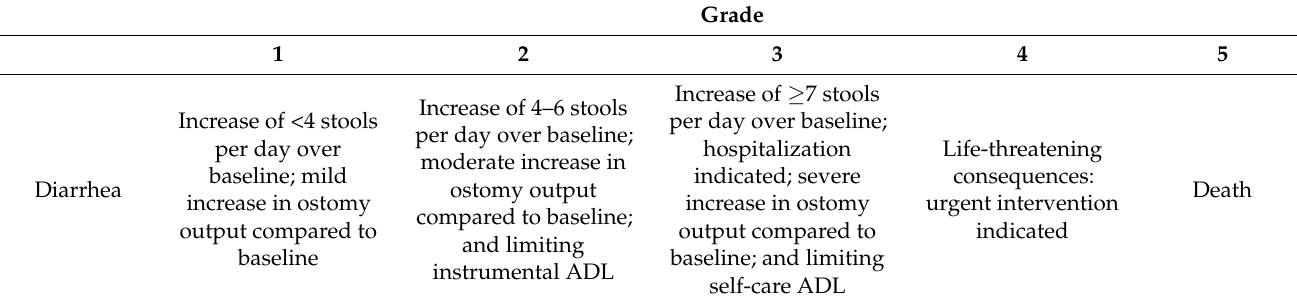
Table 1. Common Terminology Criteria for Adverse Events for diarrhea (version 5.0), adapted from the National Cancer